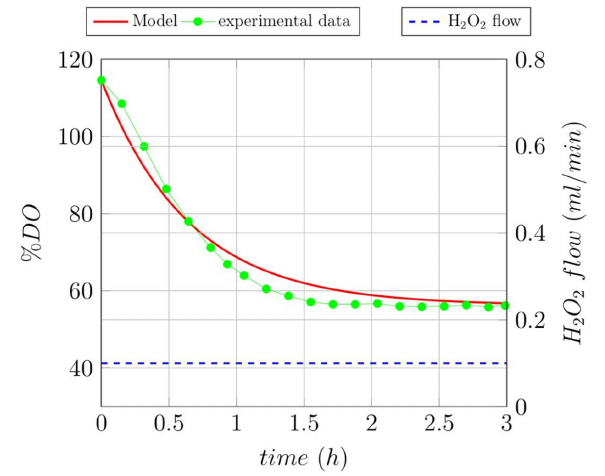
Figure 2. Degradation of Gallic acid during the Open-Loop